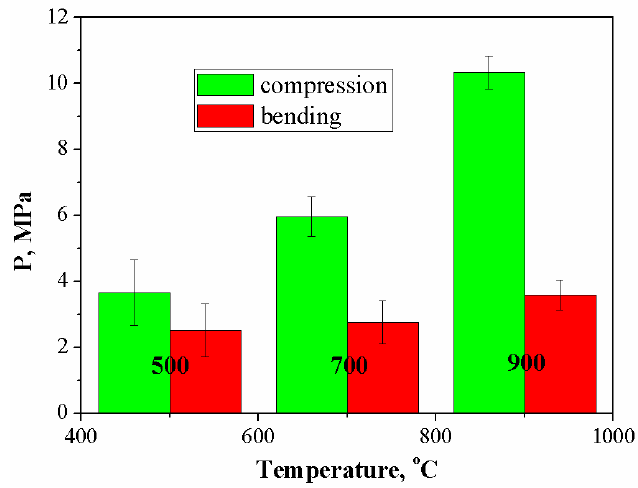
Figure 9. The compressive and bending strengths of the ceramic samples based on cement-salt stone prepared from powder mixture of citrate tetrahydrate and sodium dihydrogen phosphate after annealing at temperature range of 500–900 °C.